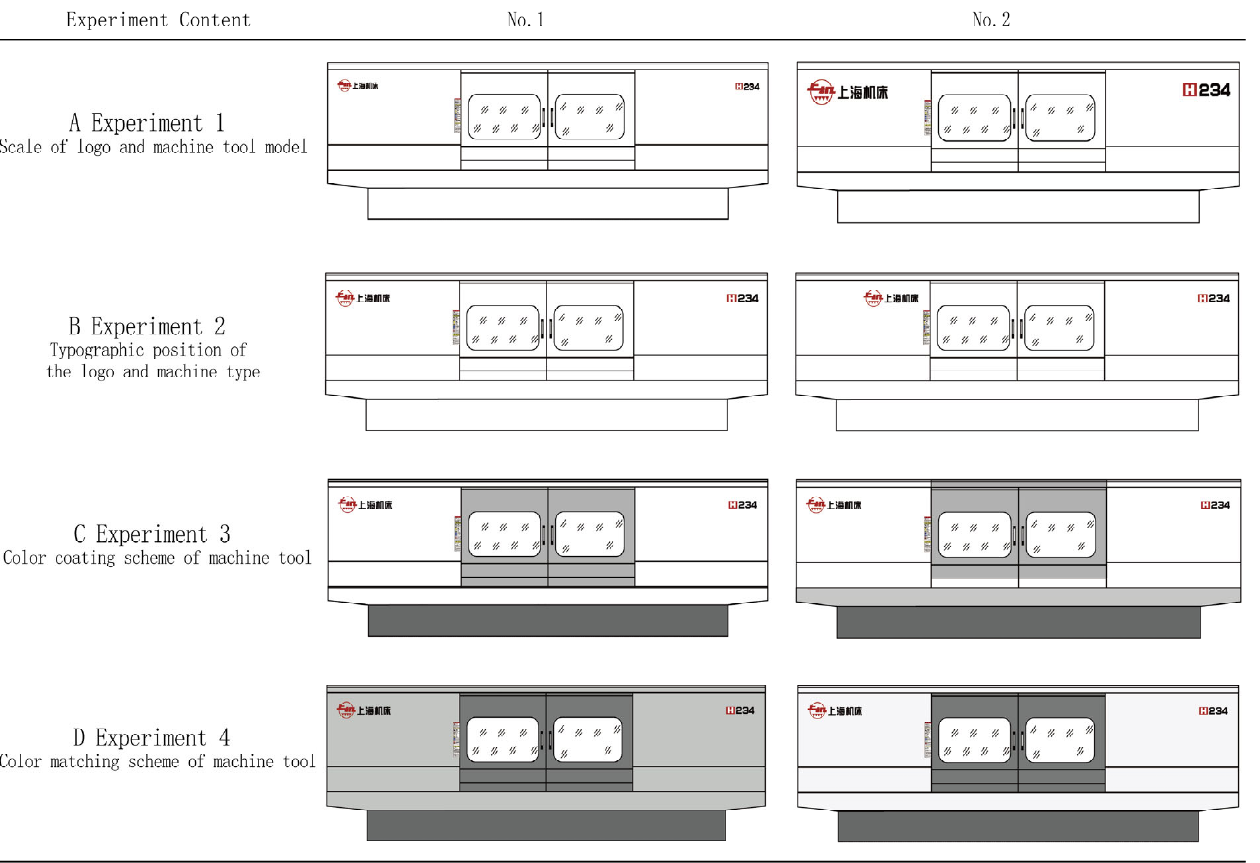
Figure 2. Photo materials for the eye ‐ tracking experiment.